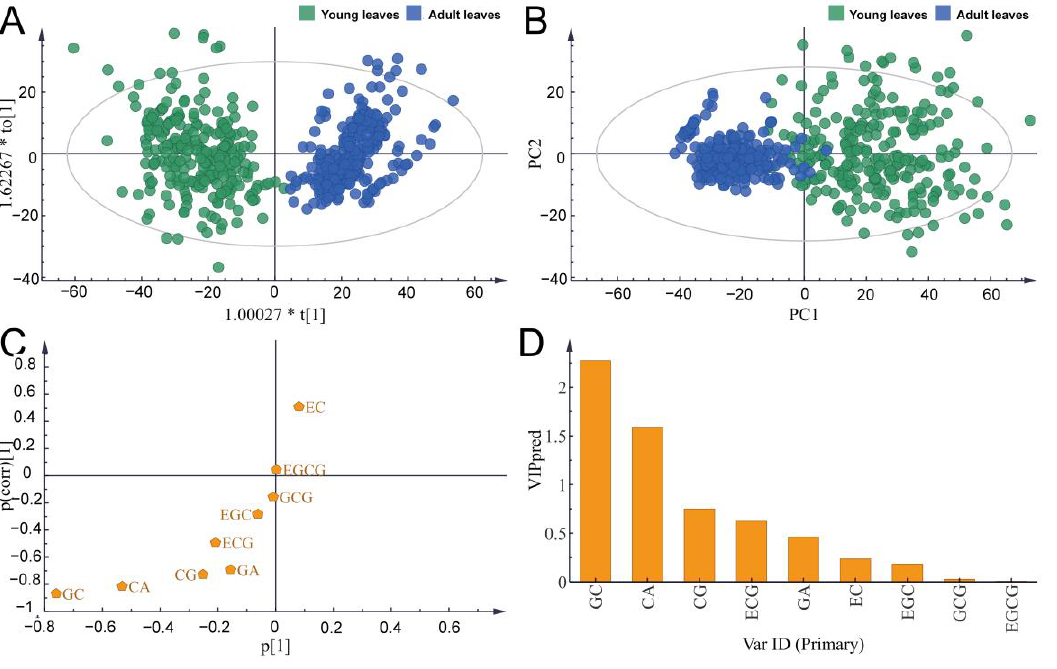
Figure 3. Differences in catechin content between young and adult leaves (( A ): PCA model; ( B ): OPLS-DA model; ( C ): S-plot; ( D ): VIP plot).